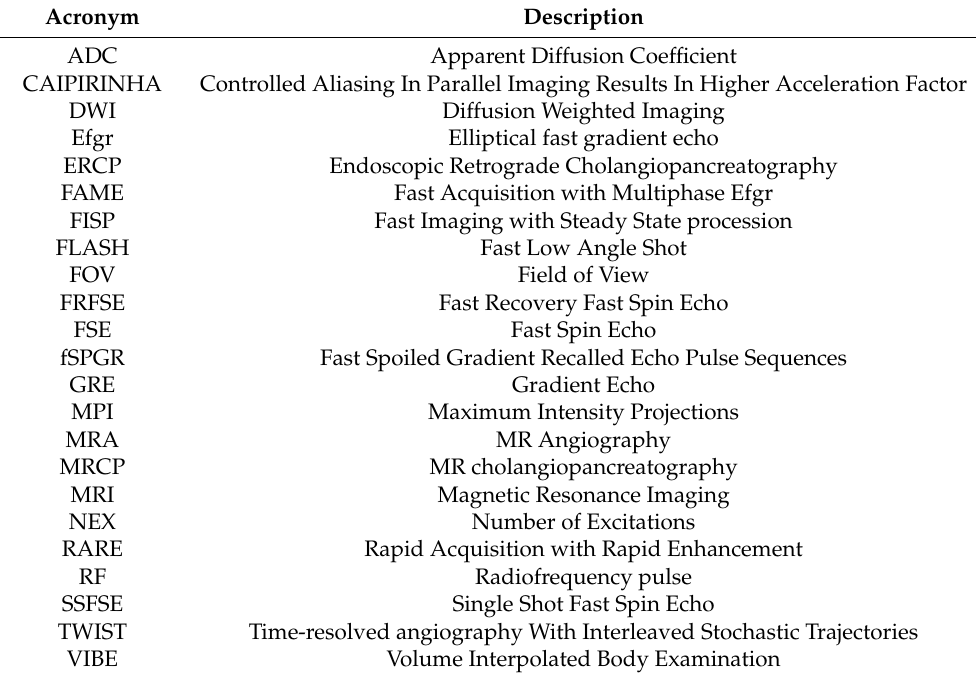
Table 1. All the acronyms used in the review are listed in the first column, with their respective extended description in the second column.